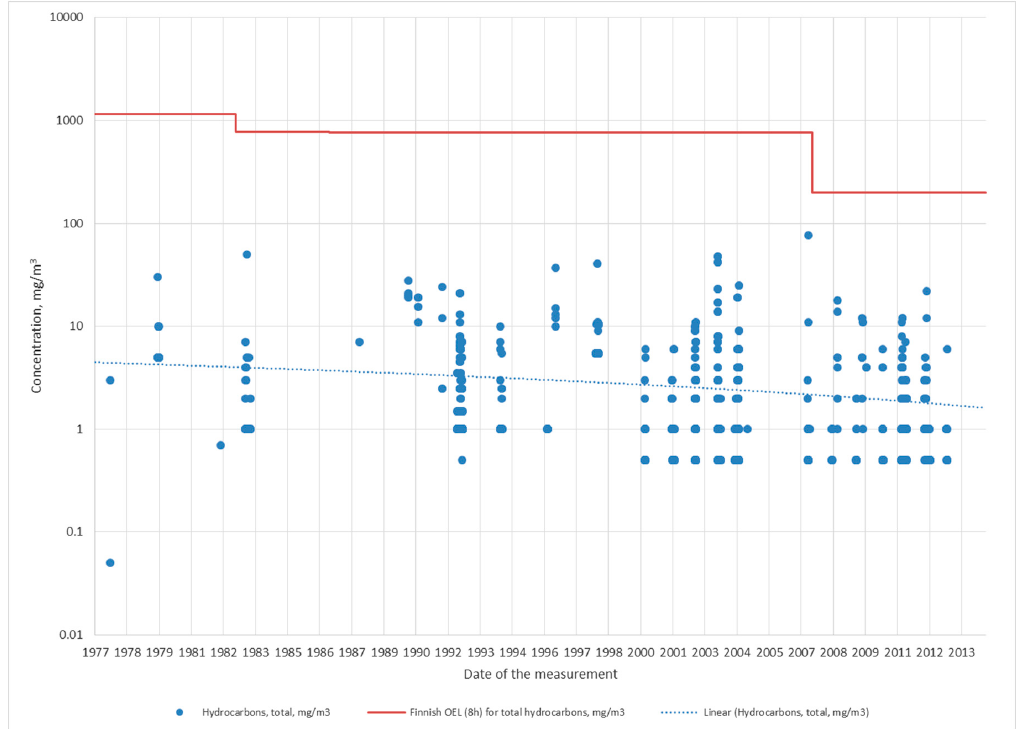
Figure 2. Hydrocarbon measurements from production lines 1–4 in Porvoo included in annual monitoring campaigns (average exposure during normal working shifts. Table 4. Development and end points of benzene air concentrations and end points of benzene exposure.